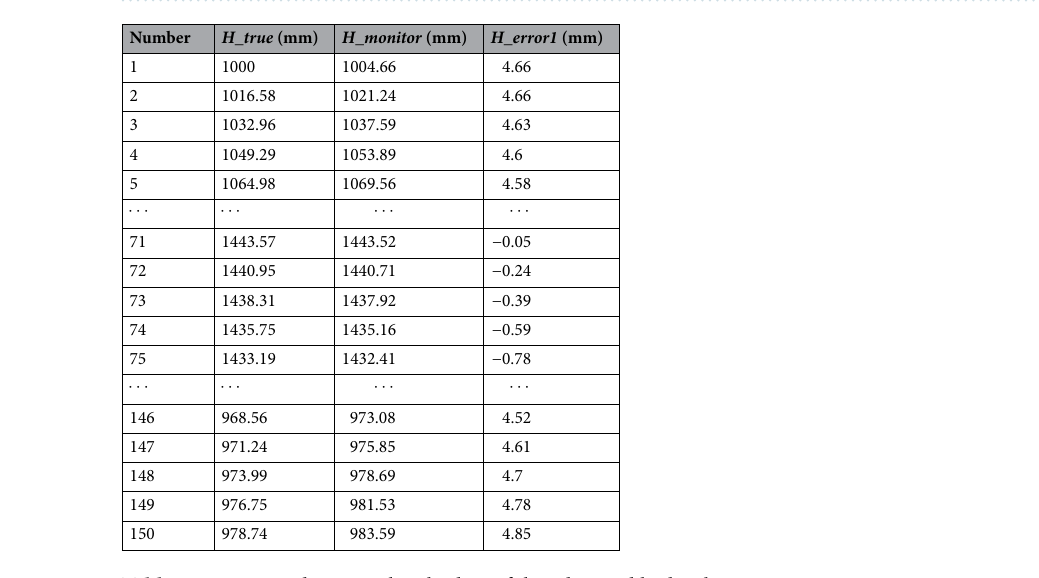
Table 19. Front end support height data of the advanced hydraulic